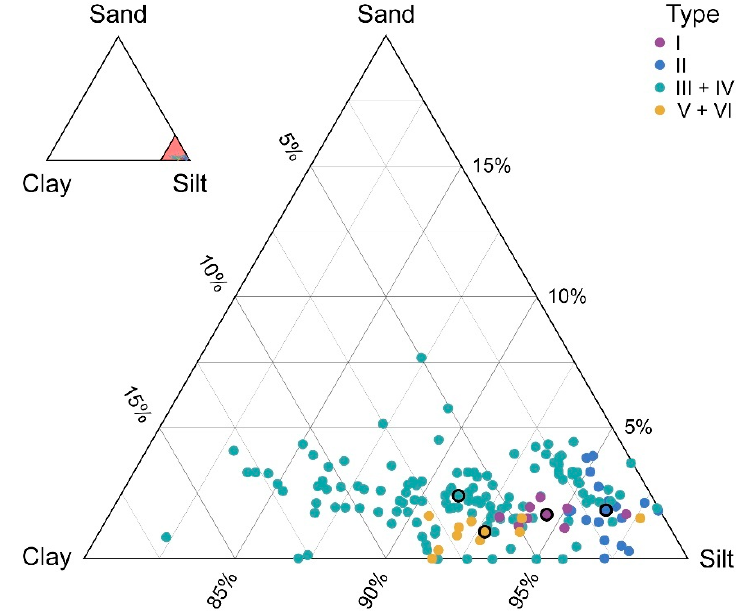
Figure 6. Ternary diagram of grain-size data. Larger points indicate values for mean grain-size distributions. The smaller triangle shows the location of samples within the full ternary diagram.